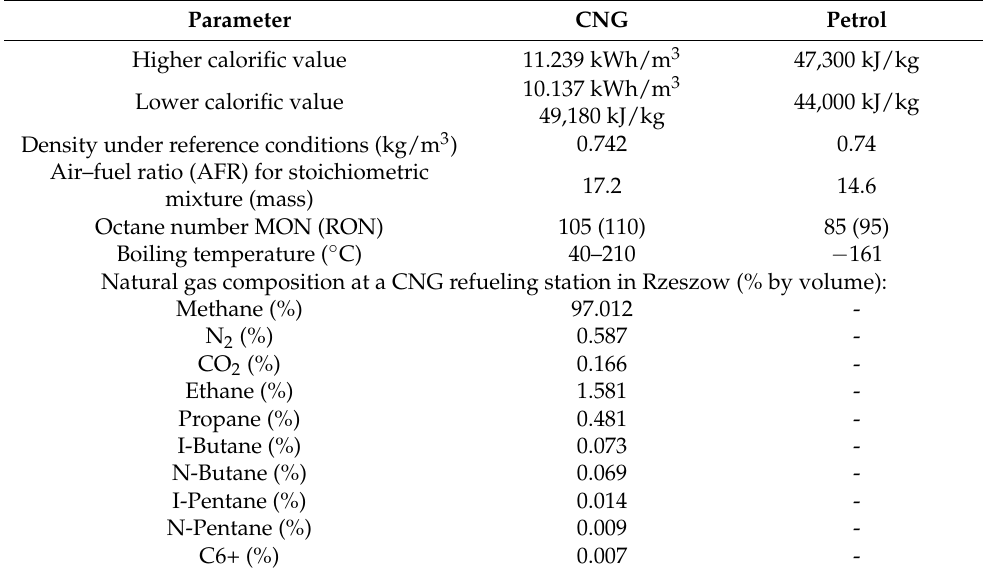
Table 2. Properties of tested fuels, where MON = motor octane number; and RON = research octane